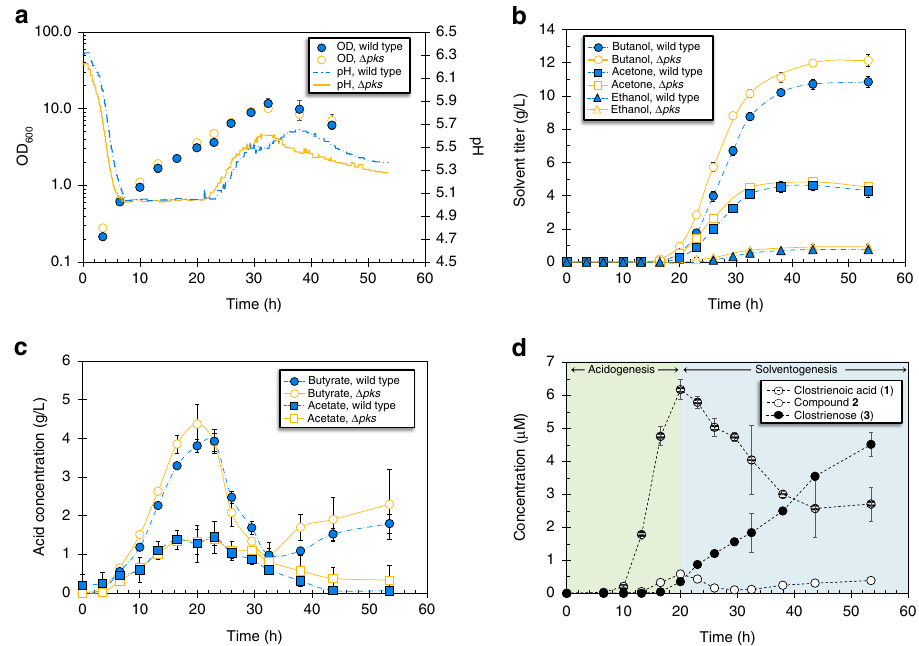
Fig. 2 Time-course batch fermentation evaluation of wild-type C. acetobutylicum and Δ pks . a Culture density (measured as optical density at 600 nm, OD 600 ) (left axis) and pH (right axis) from batch fermentations of wild type and Δ pks . b Production of acetone, butanol, and ethanol from batch fermentations of wild type and Δ pks . c Production of acetate and butyrate from batch fermentations of wild type and Δ pks . d Production of compounds 1 – 3 from batch fermentation of wild-type C. acetobutylicum ATCC 824. As indicated, the green region represents the acid production phase of the fermentation (acidogenesis), while the blue region represents the solvent production phase (solventogenesis). Error bars represent the standard deviation of values from duplicate fermentations. Experiments were repeated at least three times